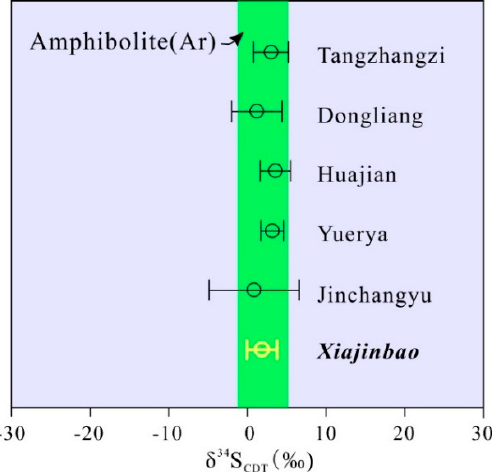
Figure 17. Sulfur isotope compositions of quartz and ore-forming fluids from the Jidong area. Sulfur isotope data of the Huajian deposit are from Shi [41] and Wang [54]; Sulfur isotope data of the Dongliang deposit are from Xin et al. [42]; Sulfur isotope data of the Jinchangyu deposit are from Zhang et al. [55]; Sulfur isotope data of the Yuerya deposit are from Jie [56]; Sulfur isotope data of the Tangzhangzi deposit are from He [57]; Sulfur isotope data of the Archean plagioclase hornblende gneiss stratum are from Lin and Guo [43].